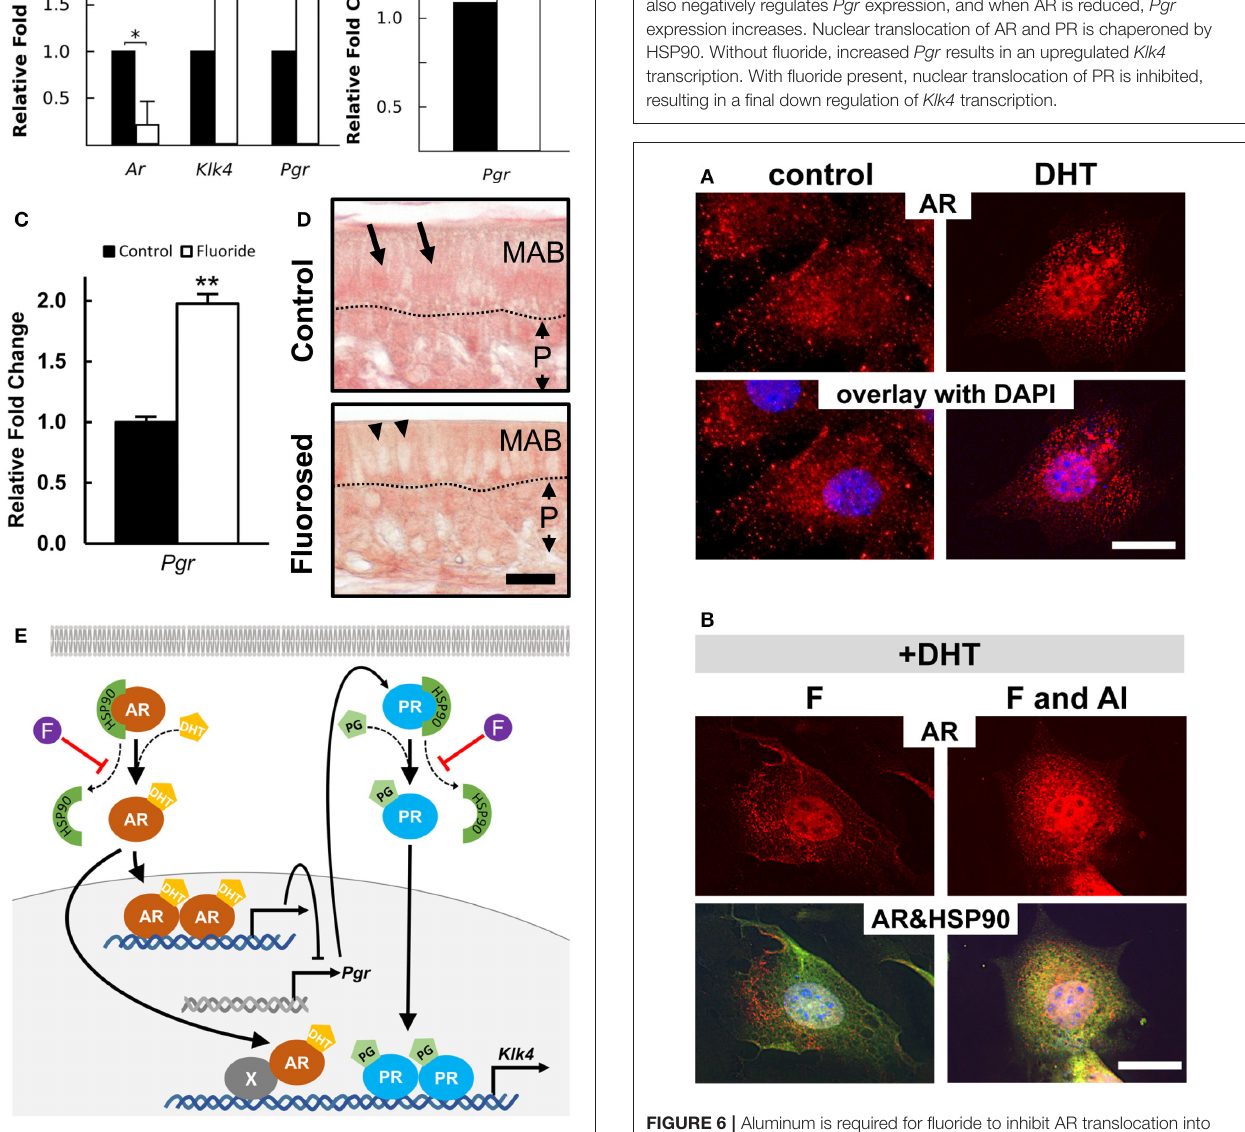
FIGURE 5 | Klk4 expression is dominantly regulated by PR. (A) Relative fold change of Ar , Klk4 , and Pgr mRNA expression of ALCs exposed to antisense LNA TM oligonucleotides targeting AR or a vehicle control. The fold change was calculated relative to the baseline expression in control mice. Expression of the target genes is normalized to the expression of EeF1a1 . * p < 0.05. (B) Relative fold change of Pgr from ALCs exposed to 0 or 1mM fluoride. Expression of target genes were normalized to the expression of EeFla1 . * p < 0.05, (C) Relative fold change of Pgr in ameloblast from fluoride exposed mice as compared to controls shows a similar upregulation of Pgr expression in vivo as compared to in vitro . ** p < 0.01, (D) Immunostaining of PR on maturation-stage ameloblasts. In control mice, intense immunostaining (in red) is seen in the nucleus of ameloblast (MAB, arrows). In fluorosed mice,